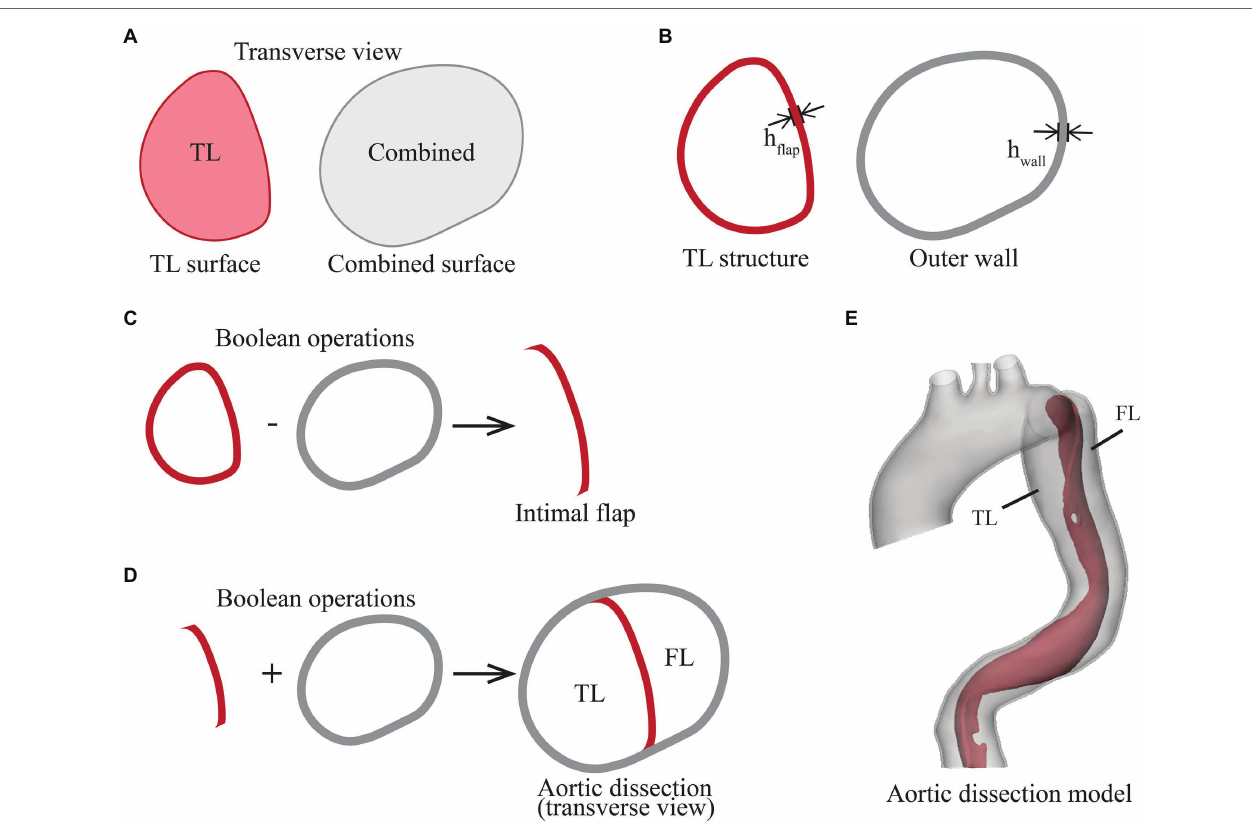
FIGURE 2 | Illustration of the steps in segmentation and reconstruction of the aortic dissection geometry from pre-TEVAR CTA scan. (A) Transverse view of two segmentations, the true lumen (TL) surface represents the original blood flow channel, and the combined surface encloses true lumen, false lumen and intimal flap, (B) the TL structure and outer wall structure were created by extruding the surfaces outwardly by 1.45 mm, (C) the intimal flap was created by performing Boolean subtraction of outer wall from TL structure, (D) the TL structure and outer wall were combined, and (E) the intimal flap and outer wall geometry were smoothed and trimmed to form the aortic dissection